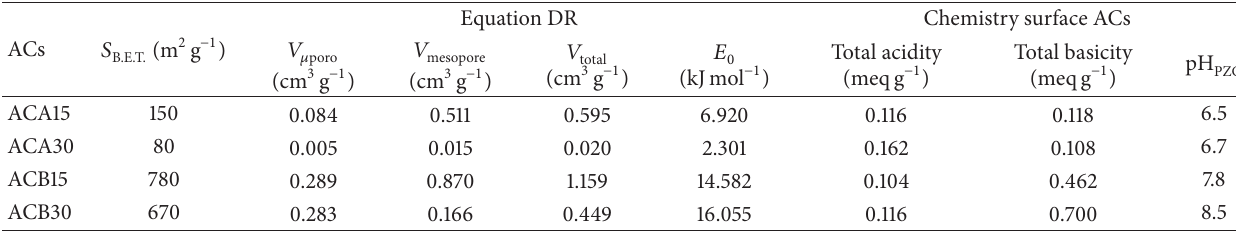
Table 1: Textural and acid-base properties of